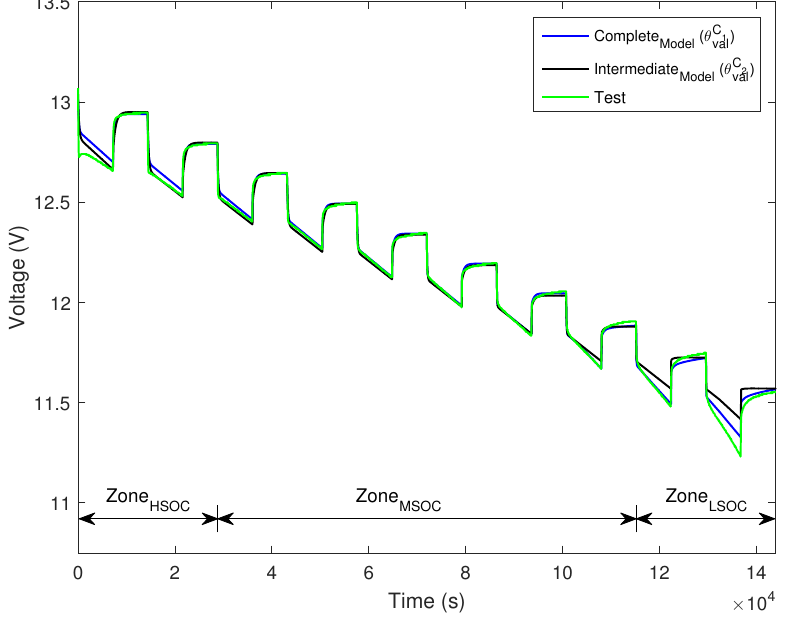
Figure 15. θ C 1